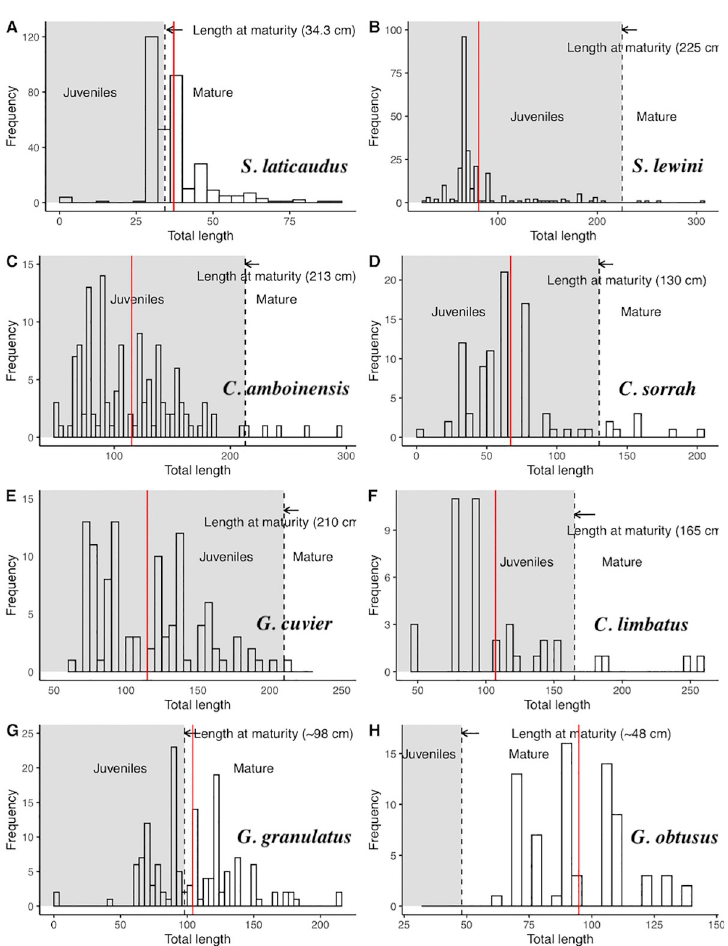
Fig 4. Length frequency with mean (red line), juveniles (shaded grey) and mature specimens of (A) S . laticaudus , (B ) S . lewini (C) C . amboinensis , (D) C . sorrah , (E) G . cuvier , (F) C . limbatus , (G) G . granulatus and (H) G . obtusus . The dashed line indicates the proportion of juveniles and the red line indicates the mean length of each